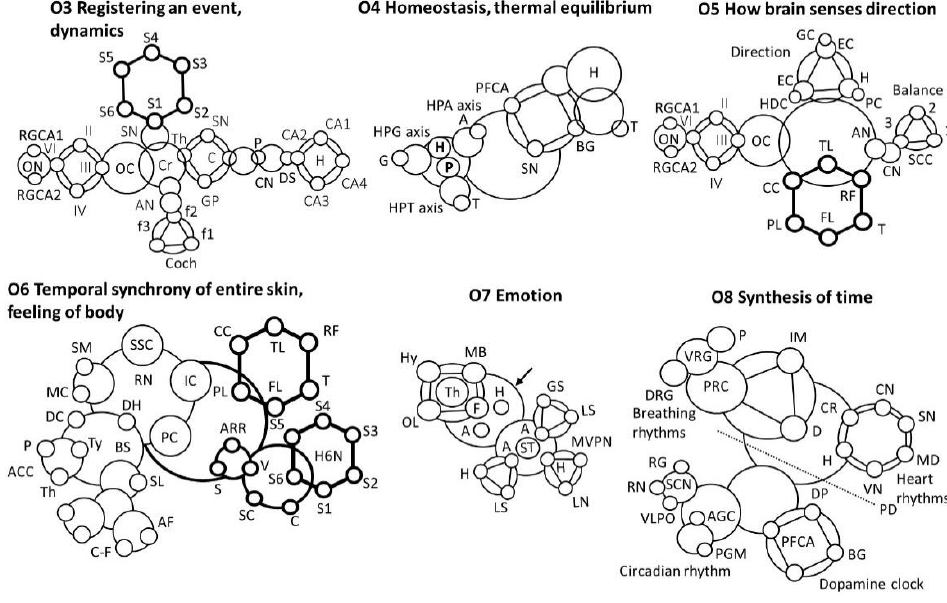
Figure 18. Octonions